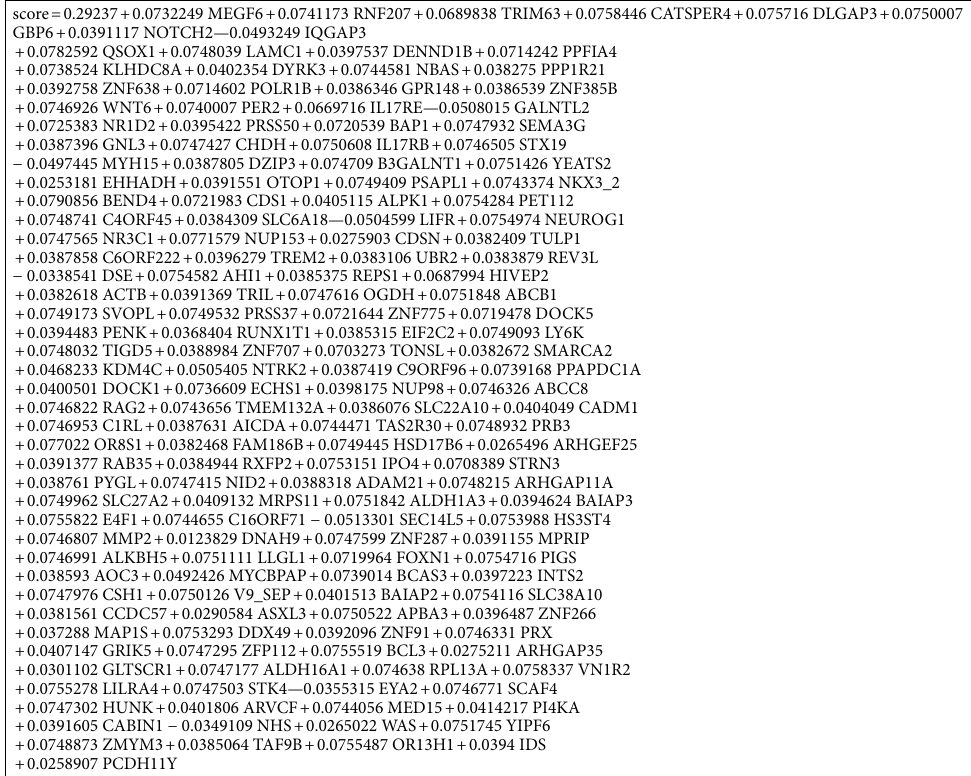
Model for metastatic melanoma; AUROC = 1.0; prob = 1.0/(1.0 + exp(+ score)) with threshold of 0.41; ROC = 1.0 and 100% of sensitivity and specificity on testing data and 0.83 on non-small cell lung cancer score = 0.29237 + 0.0732249 MEGF6 + 0.0741173 RNF207 + 0.0689838 TRIM63 + 0.0758446 CATSPER4 + 0.075716 DLGAP3 + 0.0750007 GBP6 + 0.0391117 NOTCH2—0.0493249 IQGAP3